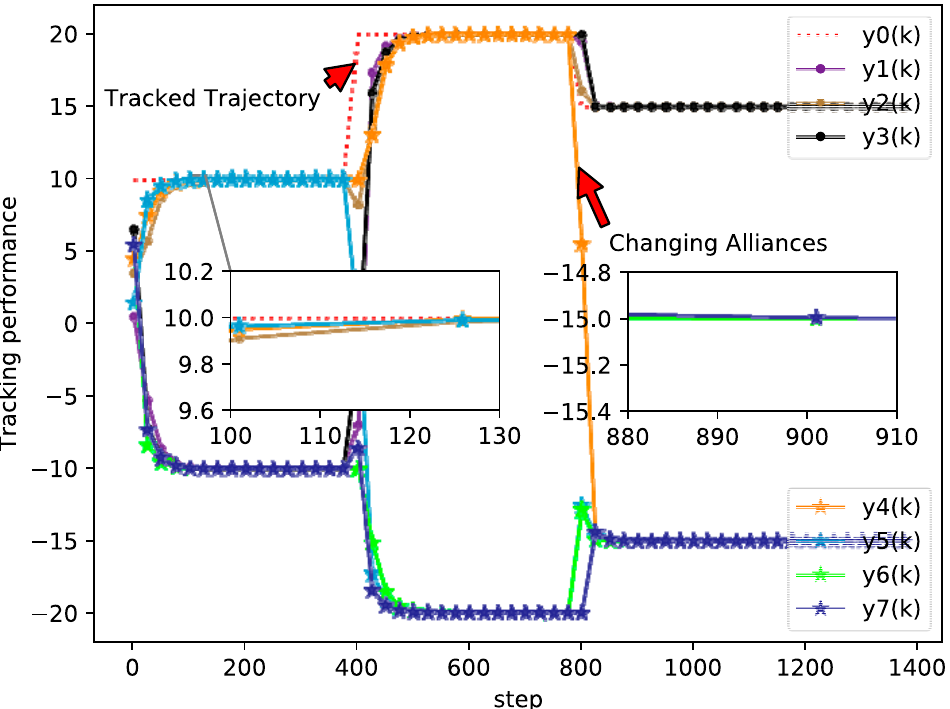
Figure 2. Tracking performance of each agent (example 1).